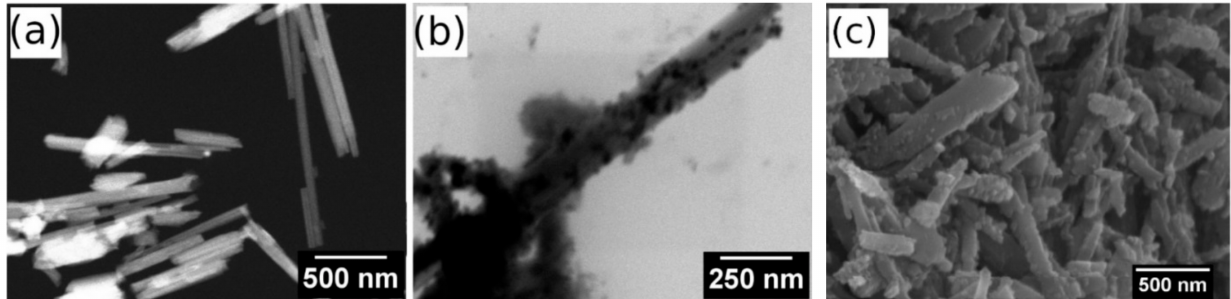
Figure 1. STEM images of ( a ) raw halloysite (STEM dark mode, magnification 100,000 × ) and ( b ) magnetized halloysite (STEM bright mode, magnification 200,000 × ; the magnetic particles are represented by black dots). ( c ) SEM image of magnetically modified halloysite.